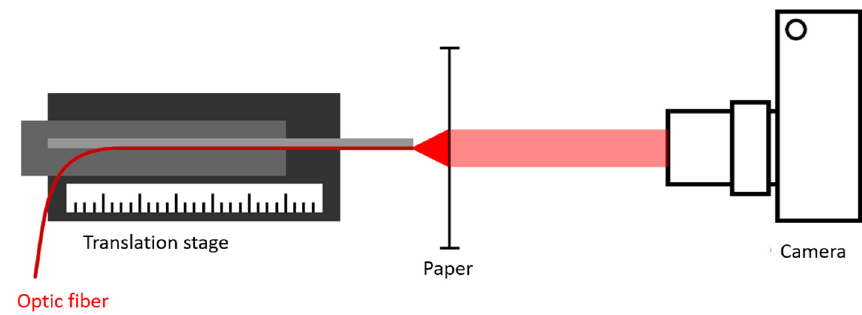
Figure 4. Schematic overview of the test setup used to quantify beam divergence.